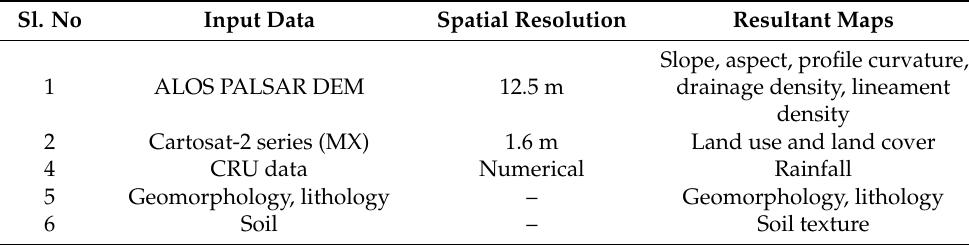
Table 1. Different data